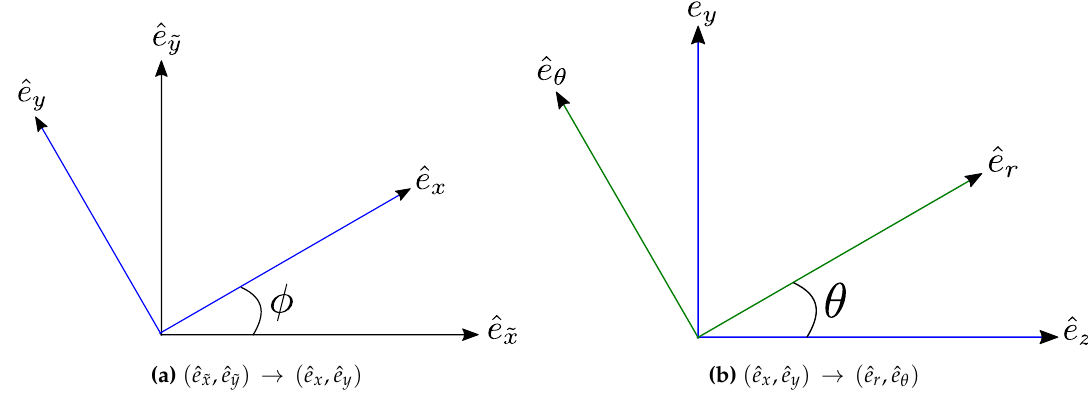
Figure A1. The three coordinate systems used and their interrelationships. The CFD simulations are performed in ( ˆ e ˜ x , ˆ e ˜ y , ˆ e z ) ; mean flow is along the ˆ e x